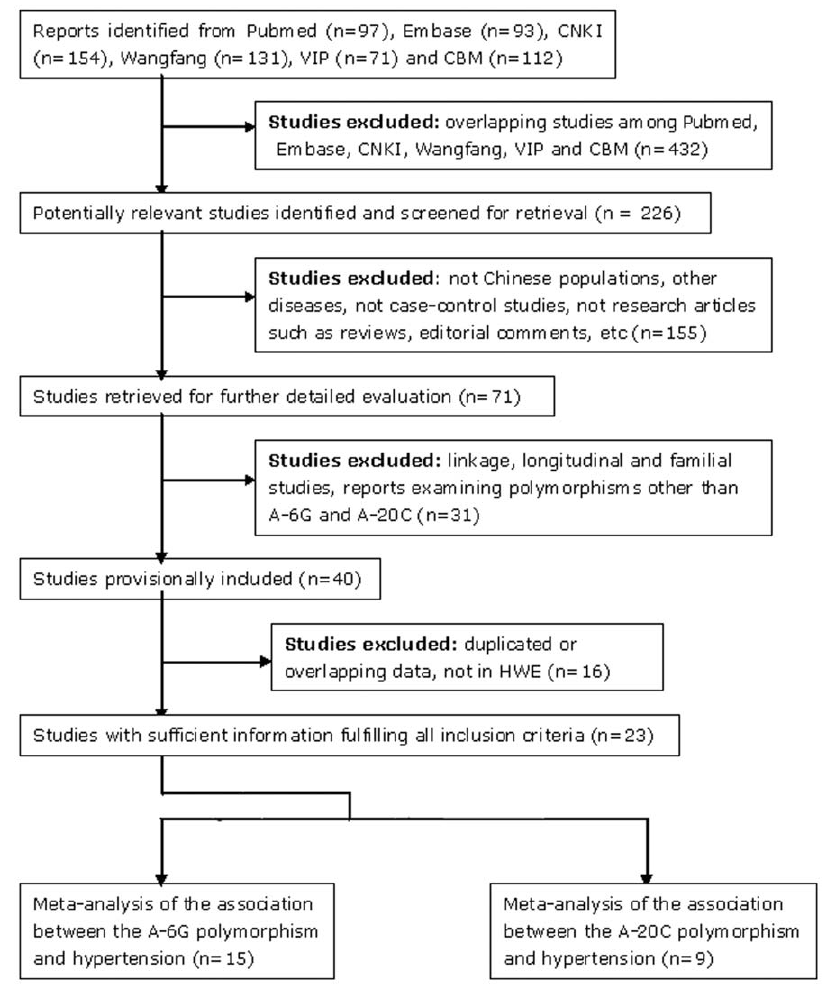
Figure 1. The flowchart of selection of studies and specific reasons for exclusion from the meta-analysis.